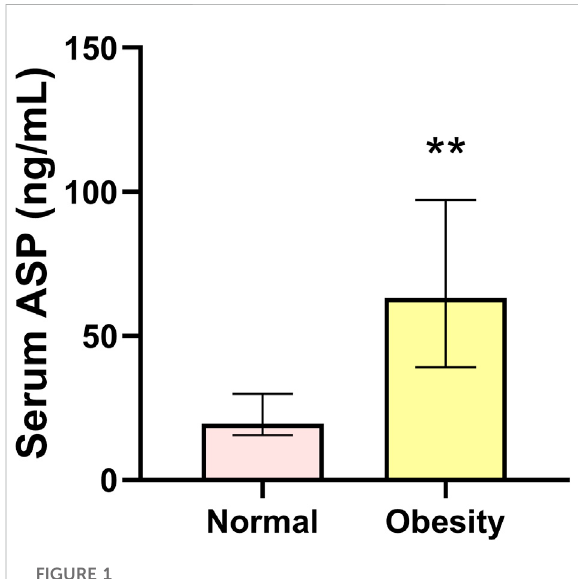
FIGURE 2 Serum asprosin levels of obese men before and after 14 weeks exercise and dietary intervention. Data are presented as medians (Me) and quartiles (Q1, Q3); Wilcoxon test ** p < 0.01 for difference from the Pre group.